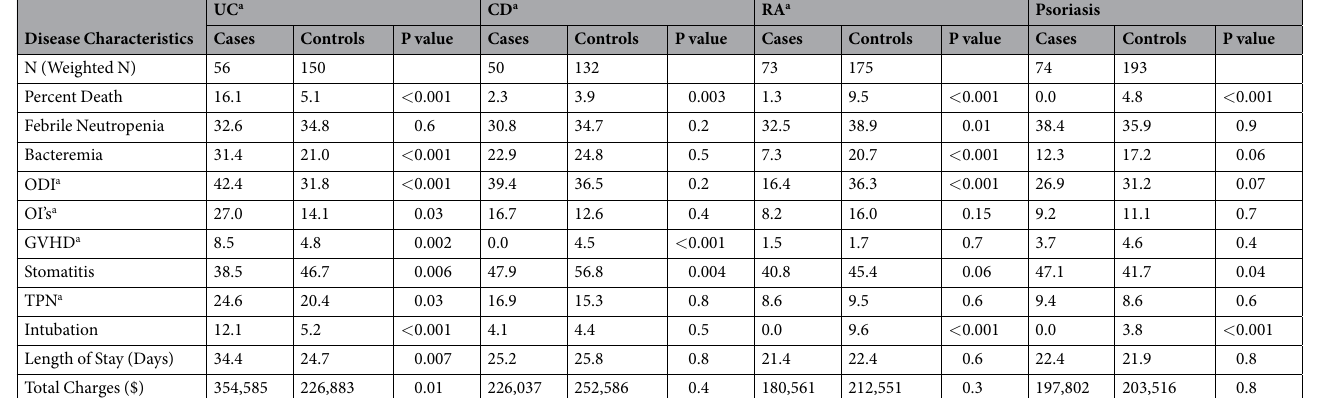
Table 3. Outcomes of HSCT in Matched Sample of Patients with Immune Mediated Inflammatory disease (UC, CD, RA, and Psoriasis) Compared to Patients without Immune Mediated Inflammatory disease. a Abbreviations: CCI, Charlson Co-morbidity Index; TBI, Total Body Irradiation; ODI, Other Documented Infections; OI’s, Opportunistic infections; GVHD, Graft Vs. Host Disease; TPN, Total Parenteral Nutrition; UC, Ulcerative Colitis, CD, Crohn’s Disease; RA, Rheumatoid Arthritis; HSCT, Hematopoietic Stem Cell Transplantation.